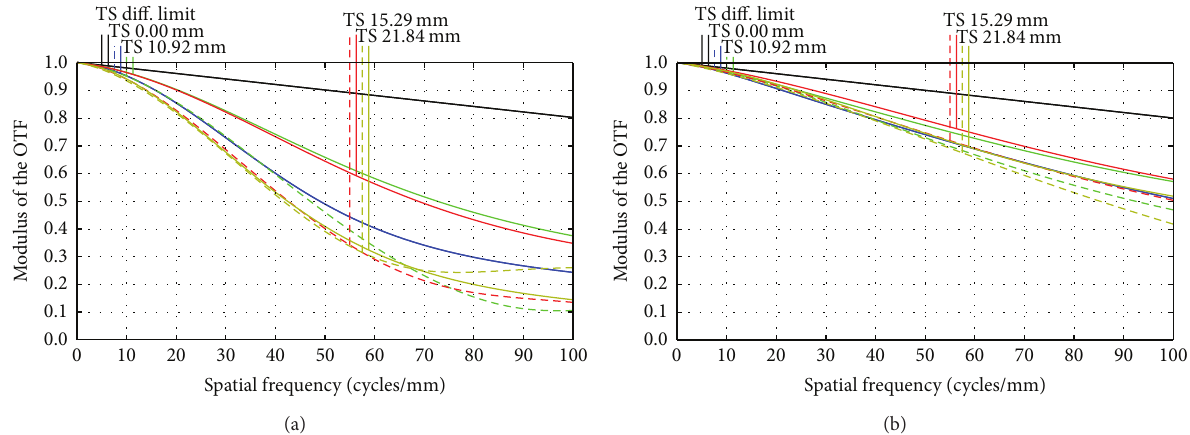
Figure 8: Polychromatic MTF for 436 nm to 656 nm for infinite object distance: (a) patent data and (b) final design.